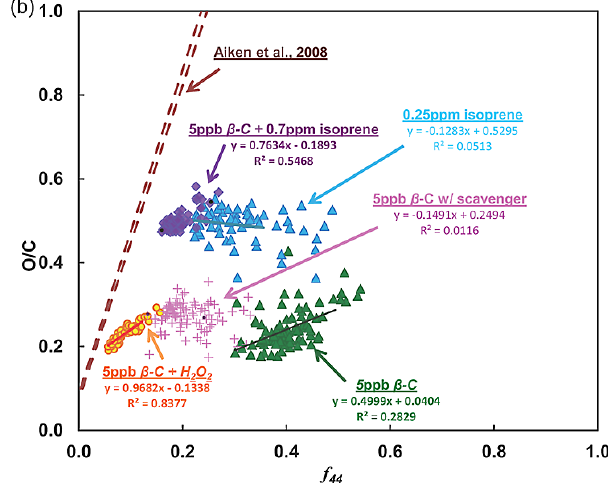
Fig. 3b. Scatter plot of aerosol f 44 as a function of O/C with equa- tion and R 2 of linear regression fit. The two dashed lines repre- sent upper and lower bound of f 44 -predicted O/C using the empir- ical correlation of f 44 and O/C described in Aiken et al. (2008), f 44 = ( 0 . 0382 ± 0 . 0005 ) × (O/C)+(0.0794 ±